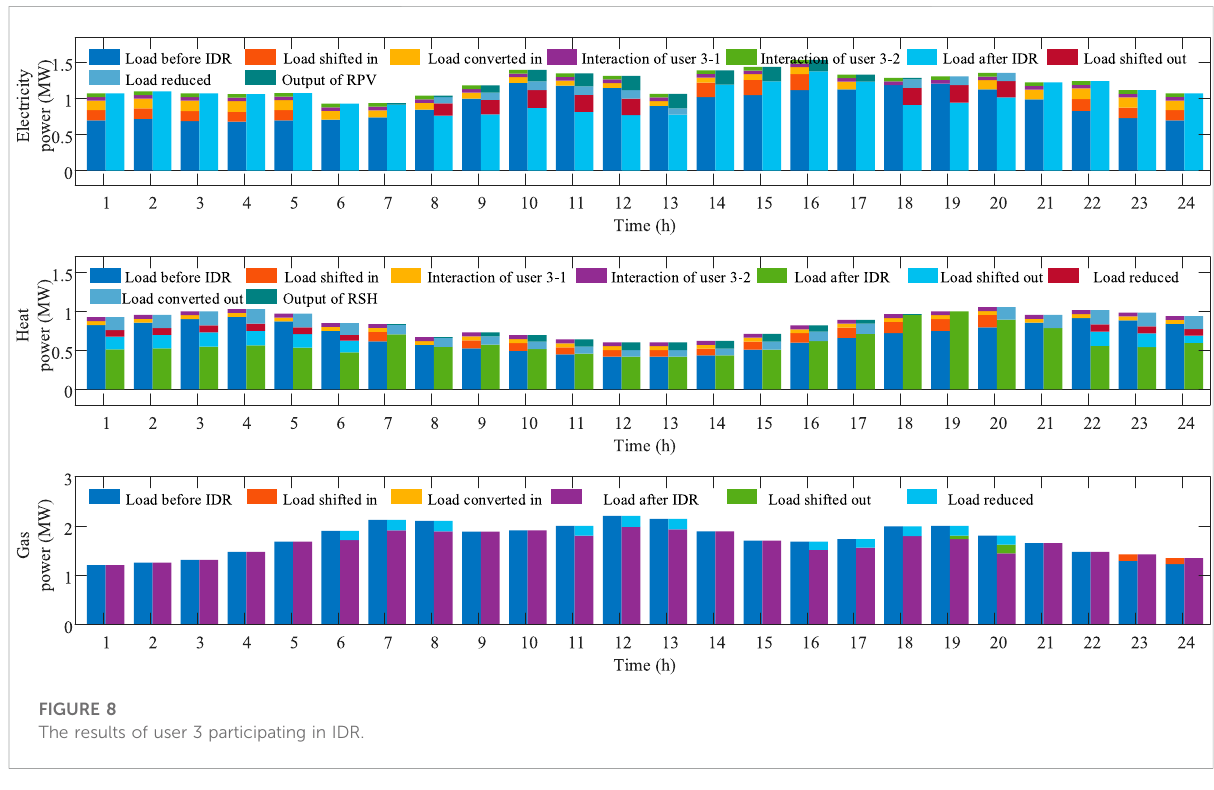
FIGURE 8 The results of user 3 participating in IDR.